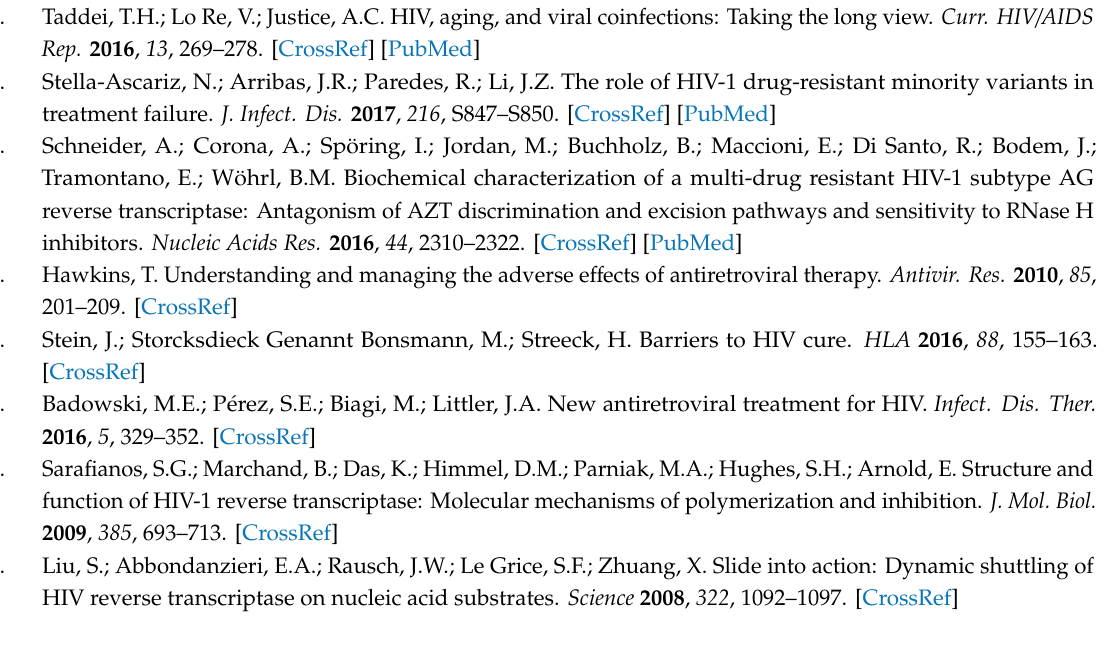
Supplementary Materials: The following are available online, Figure S1: E ff ect of MgCl 2 on the spectrum of absorbance of compounds 12g , 13g , 14g , 15g , 16hh , 17h , and 18g ; Figure S2: 2D and 3D representation of 17h binding mode produced by docking studies on 3LP1 structure; Figure S3: E ff ect of compounds 12g , 13g , 14g , 15g , 17h , and 18g on the fluorescein-based assay condition; Table S1: #Pprobes generated by FTmap for the analyzed crystal structures; Table S2: Predicted Ligand Binding Energy (LBE), predicted Ki (Ki pred ) and number in cluster (NiC) for docked